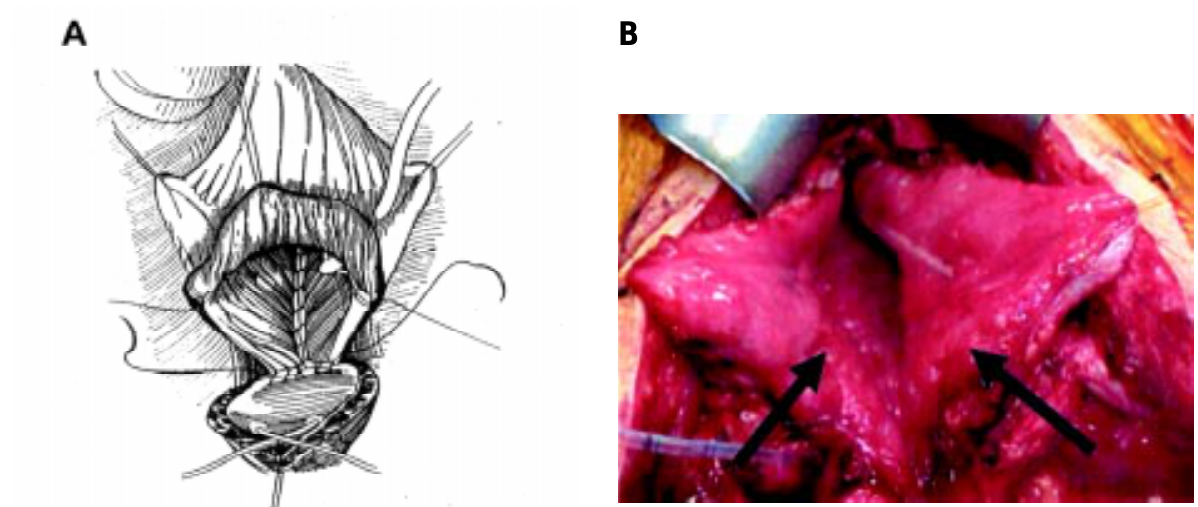
Figure 3 - Anastomosis of the bowel segment to an open bladder plate. A) Diagram of the open bladder. B) Intra-operative photo of the clamed shelled bladder, with arrows pointing to each bladder half. (From Hinman F Jr: Atlas of Pediatric Urology. Philadelphia, W.B. Saunders Co., 1994, with permission).